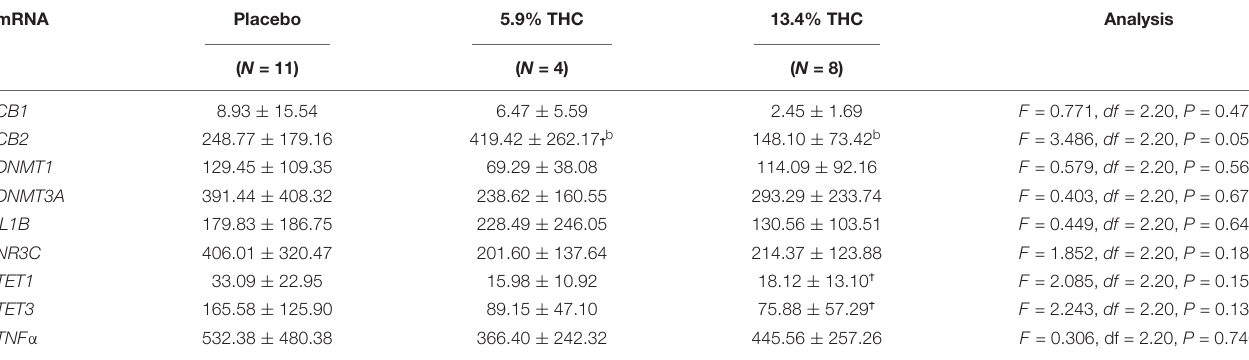
TABLE 3 | Baseline mRNA levels in the three treatment